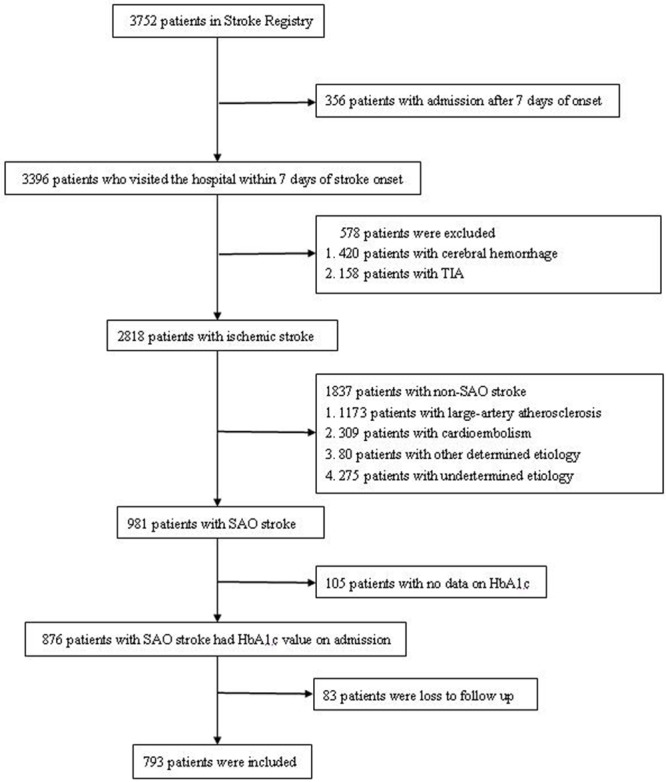
Flow chart of patient selection.SAO: small-artery occlusion; HbA1c: hemoglobin A1c.